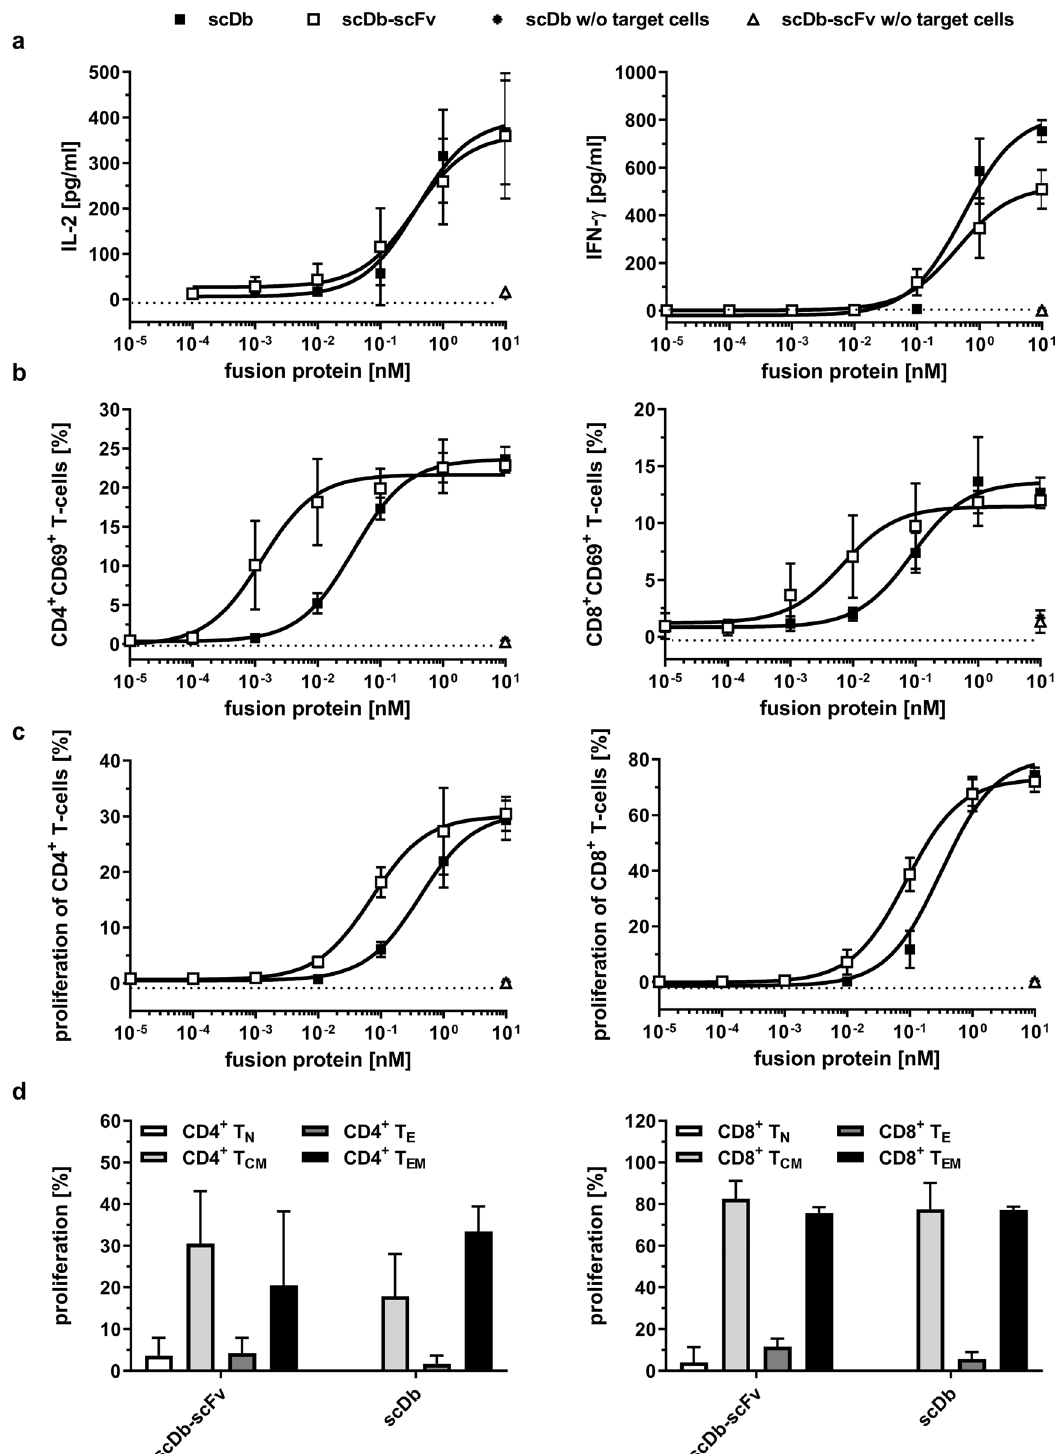
Figure 3. Activity of scDb and scDb-scFv on cytokine release, T-cell activation and proliferation. ( a ) IL-2 and IFN-γ release and ( b ) CD69 expression of CD4 + and CD8 + T-cells mediated by scDb and scDb-scFv. PBMCs were co-cultured with MCF-7 cells in presence of fusion protein. Cytokine release was determined after 24 h (IL-2) or 48 h (IFN-γ) using sandwich ELISA. CD69 expression on T-cells was analyzed after 24 h in flow cytometry. ( c ) Proliferation of CD4 + and CD8 + T-cells was measured by CFSE dilution in flow cytometry. ( d ) Proliferation of naïve (T N , CD45RA + , CCR7 + ), central memory (T CM , CD45RA − , CCR7 + ), effector (T E , CD45RA + , CCR7 − ) and effector memory (T EM , CD45RA − , CCR7 − ) subpopulations of CD4 + T-cells and CD8 + T-cells was determined by CFSE dilution in flow cytometry. Mean ± SD of three independent experiments (n = 3) using PBMCs from one donor for each analysis. In total, PBMCs from 4 different donors were